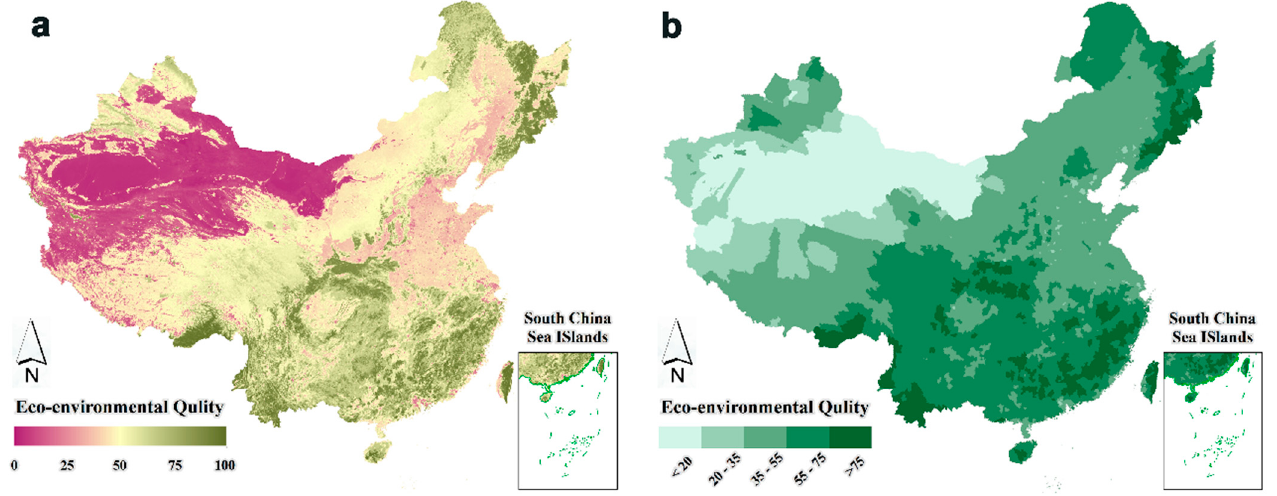
Figure 3. Spatial distribution maps of EEQ (CHEQ) in China in 2018. Spatial distribution map of EEQ in China in 2018 ( a ) at the 1000 m grid scale and ( b ) at the country scale.